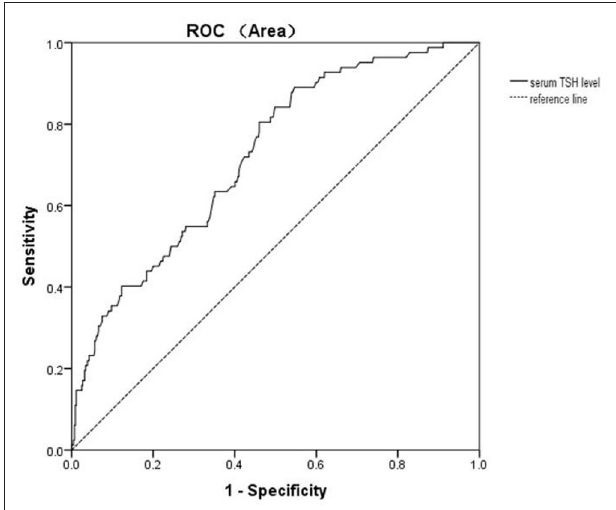
FIGURE 1 | Diagnostic accuracy of serum TSH level for A-MDD in young FEDN MDD patients with SCH. The area under the ROC curve is 0.721 on serum TSH